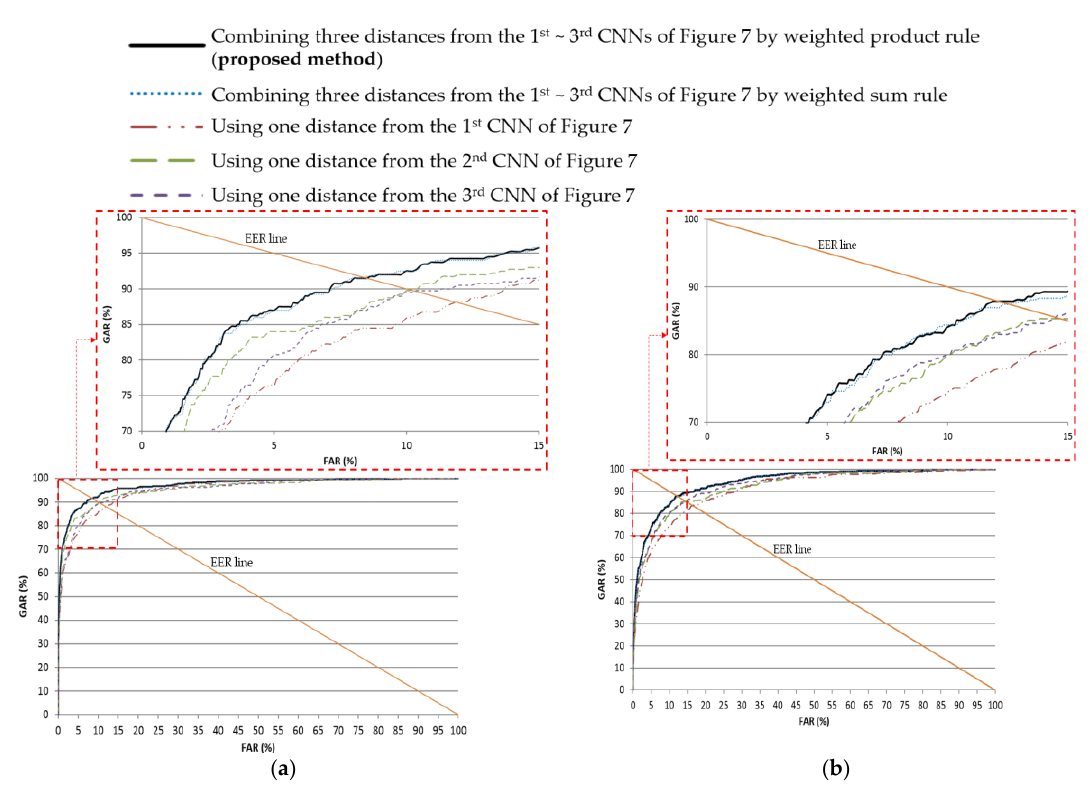
Figure 10. ROC curves of recognition with testing data. ( a ) First fold cross-validation; ( b ) second fold cross-validation.